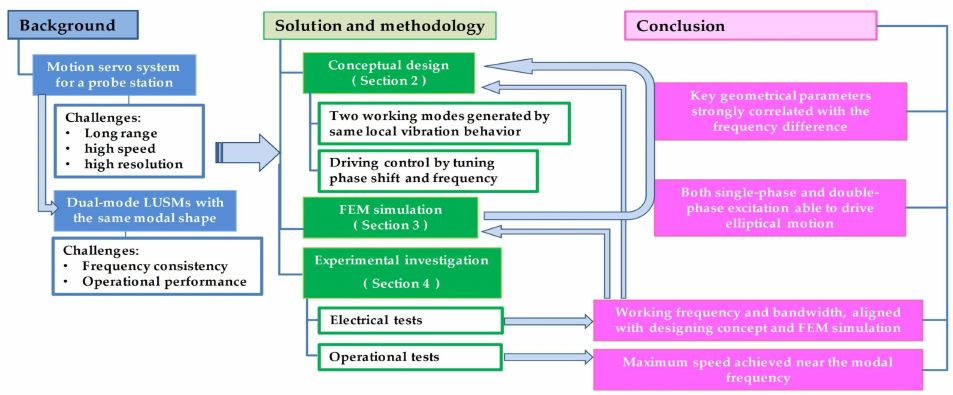
Figure 1. Graphical abstract.